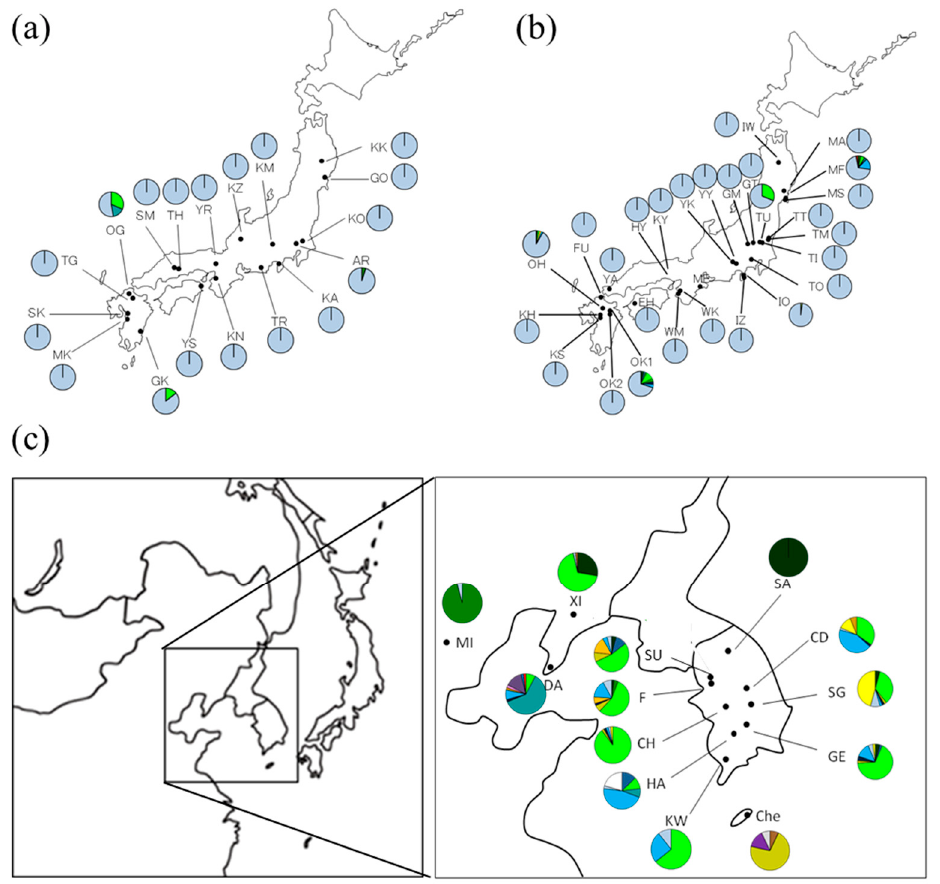
Figure 1. Chloroplast haplotype distribution of Quercus acutissima Carruth. for ( a ) 18 natural populations in Japan, ( b ) 28 artificial populations in Japan and ( c ) 13 continental populations. The color of haplotype is same as Figure 2.